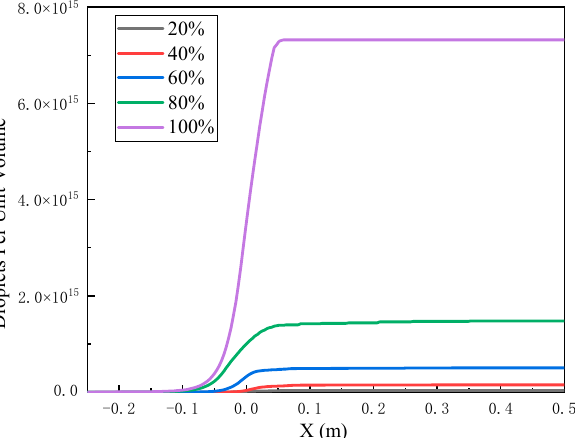
Figure 9. Droplets per unit volume distribution along the Moore type “B” nozzle centerline for several relative air humidity levels.